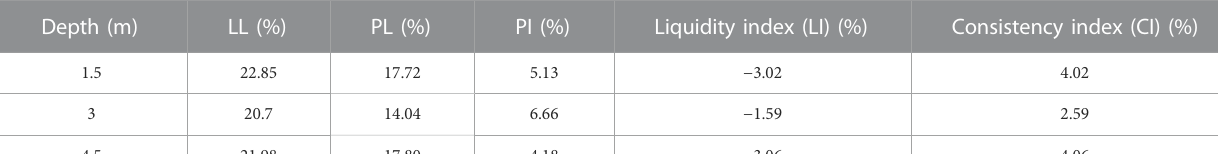
TABLE 4 Consistency results of Najran soil specimens.